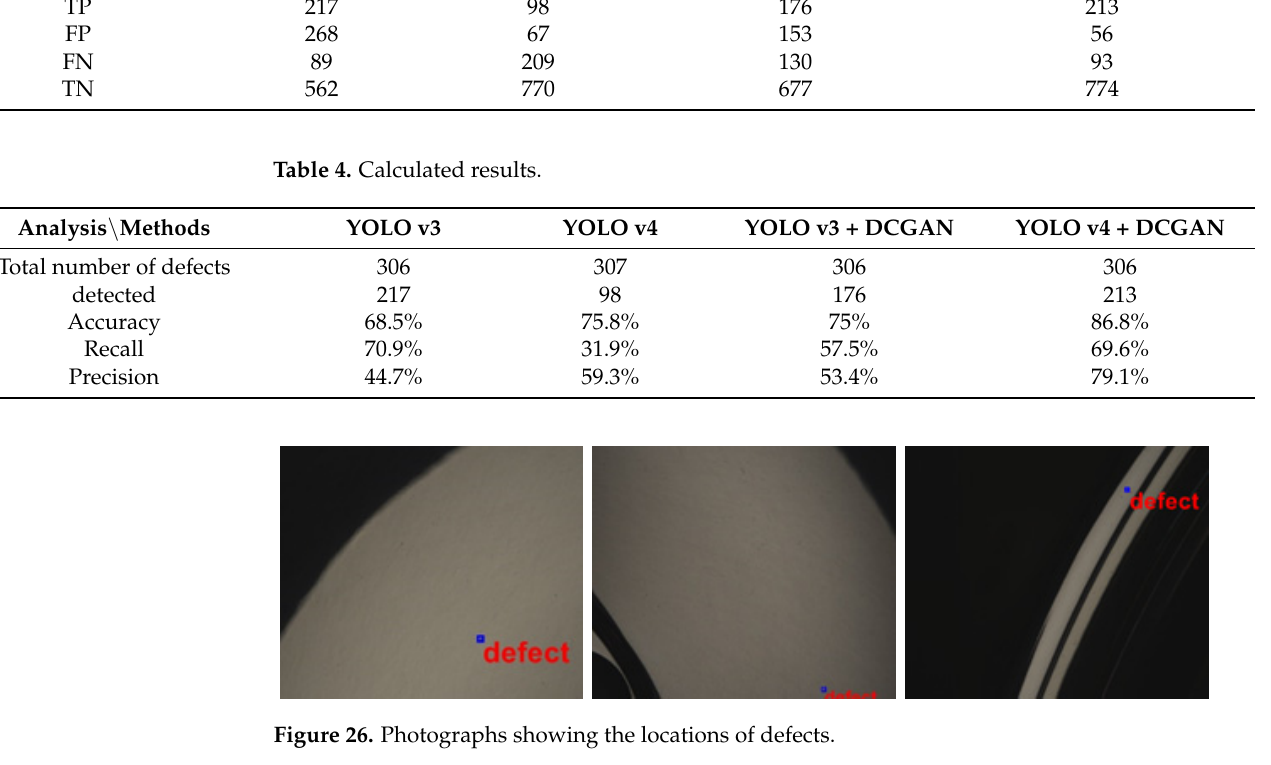
Figure 25. Training results for YOLO v4: ( a ) original images only ( b ) original images plus DCGAN synthetic images. Table 3. Model prediction data. The second stage of testing was performed using eight rims, comprising 25 defects. Model prediction data are listed in Table 3, and the calculation results are listed in Table 4. In the test results in Figure 26, defects are indicated by boxes.